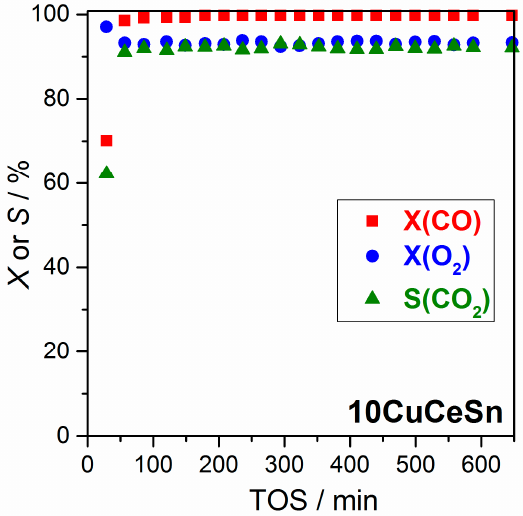
Figure 2. Results of the stability test for 10CuCeSn at 200 °C (reaction mixture: 4 vol.% CO, 3 vol.% O 2 , 13 vol.% N 2 and 80 vol.% H 2 ).